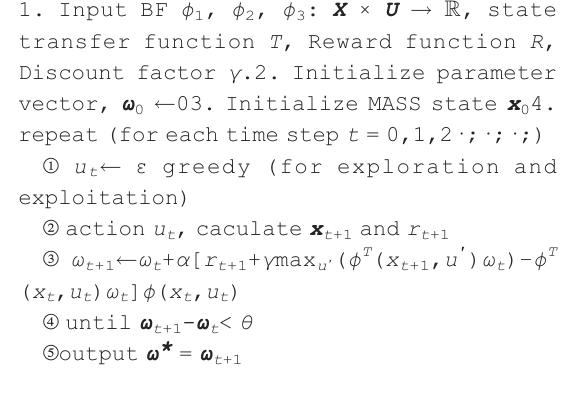
Algorithm 1. Q-valued function approximation learning algorithm based on gradient descent